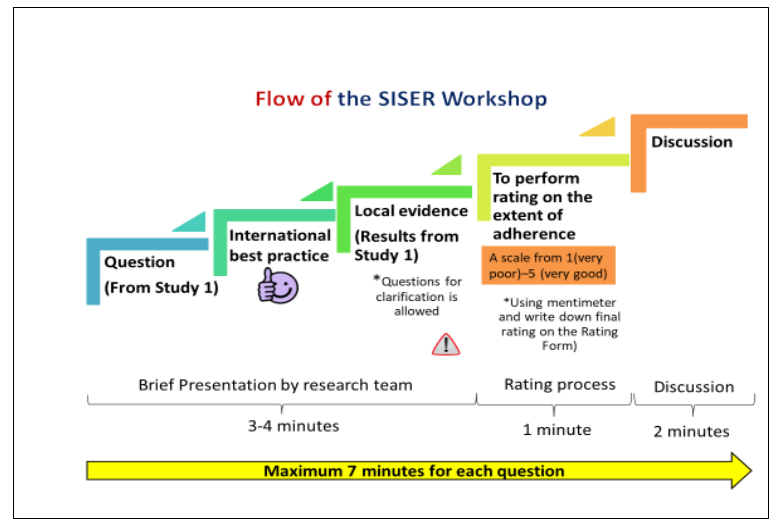
Figure 1. Process Flow from Question to Discussion in the SIS-ER Workshop.